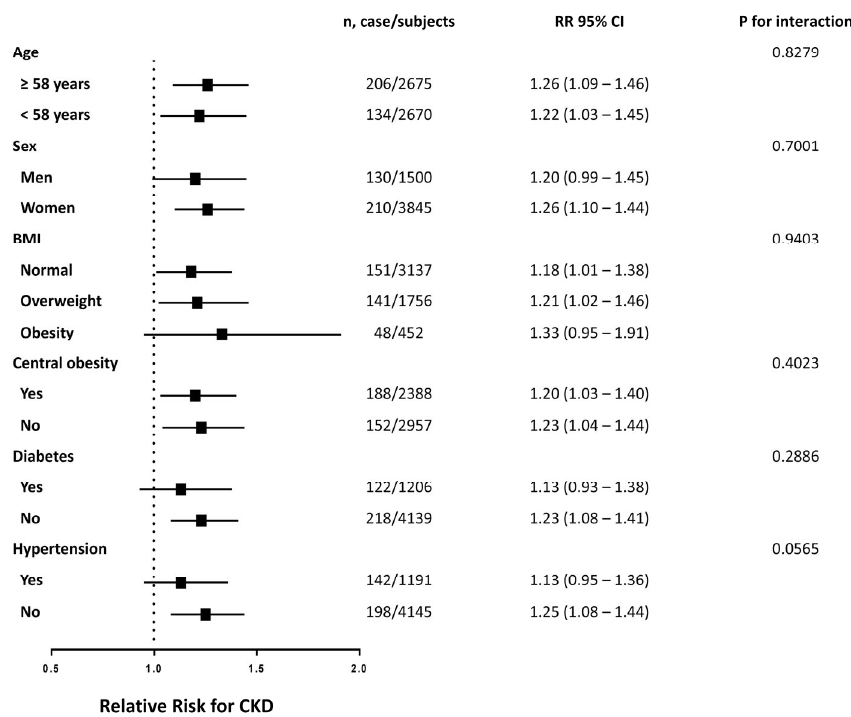
Figure 3. Risk of incident CKD with each quartile increase of TG/HDL ‐ C in different subgroups at follow up. The model is adjusted for age, sex, BMI, current smoking status, current drinking status, physical activity level and previously ‐ diagnosed dyslipidemia.